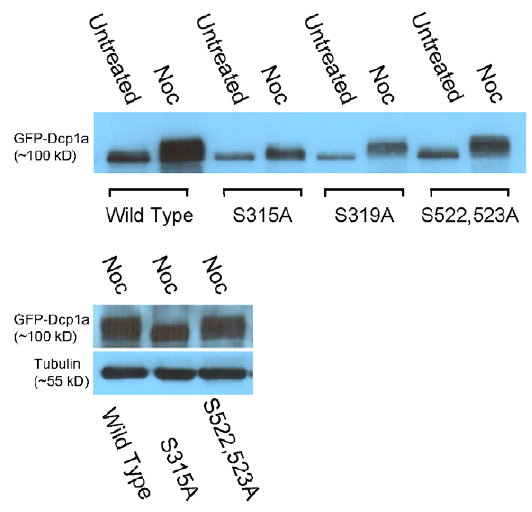
Figure 8. Serine 315 is important for the hyper-phosphoryla- tion of Dcp1a during cell division. Top - The S319A and S522,523A mutated GFP-Dcp1a proteins showed prominent hyper-phosphoryla- tion patterns compared to the S315A protein. Bottom - blot comparing the mobility shifts of the mutated proteins from mitotic cell extracts showing that S315A is the least affected.